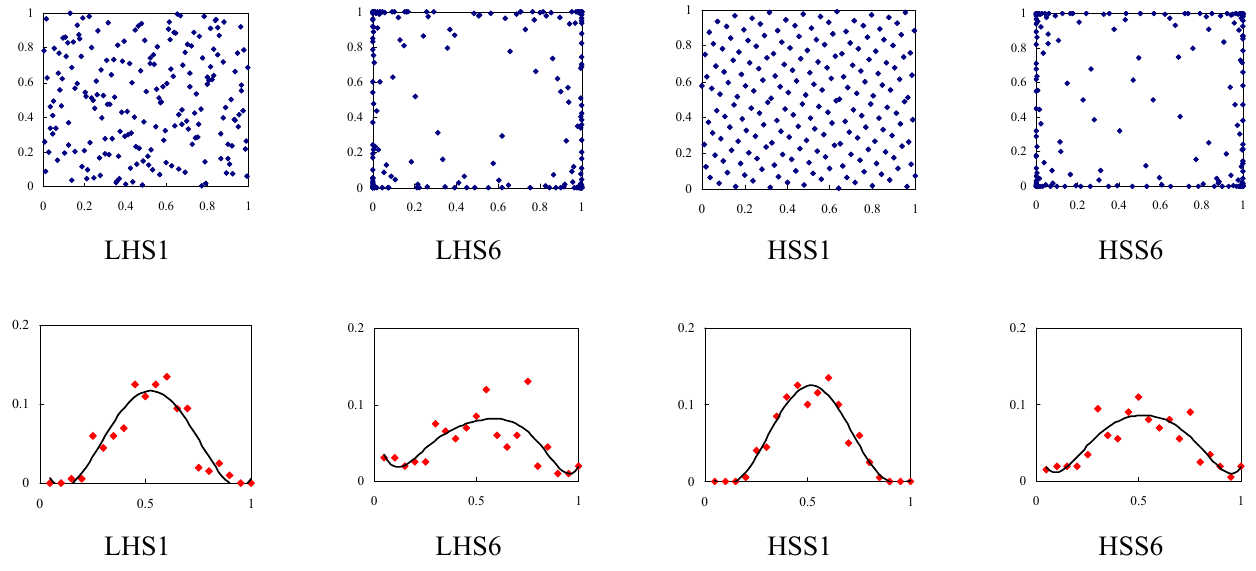
Fig. 3. Margin processing conducted in sampling. (a) Joint distribution of two individual variables (200 samples in [0 ∼ 1]). (b) Distribution density of weighted mean of 4 random variables which equals 4 individual variables respectively multiply the “weight coefficients”( A(i) ) which were set to be A(i)